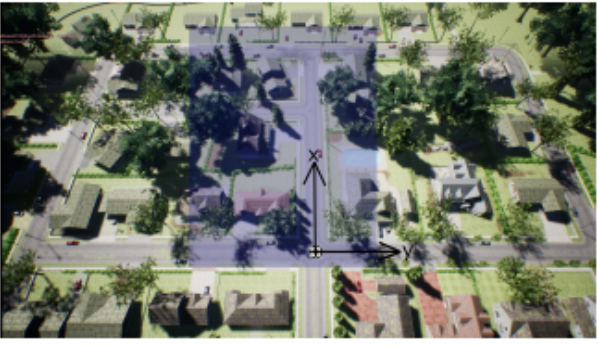
Figure 4. The neighbourhood environment.